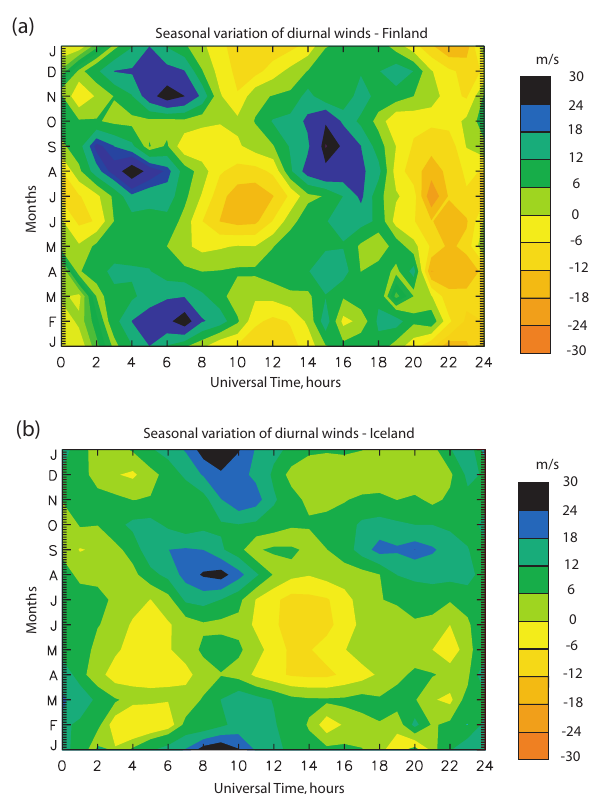
Fig. 10. Seasonal and diurnal line-of-sight horizontal winds (posi- tive towards the north-northeast direction) for the CUTLASS pair of SuperDARN radars between January and December 1997 (a) Fin- land beams 10–15 (b) Iceland East beams